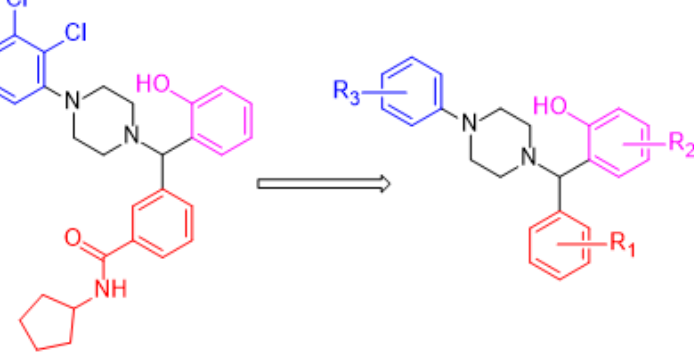
Figure 1. Changes in NPB structure after replacement with new R1, R2, and R3 groups is shown.